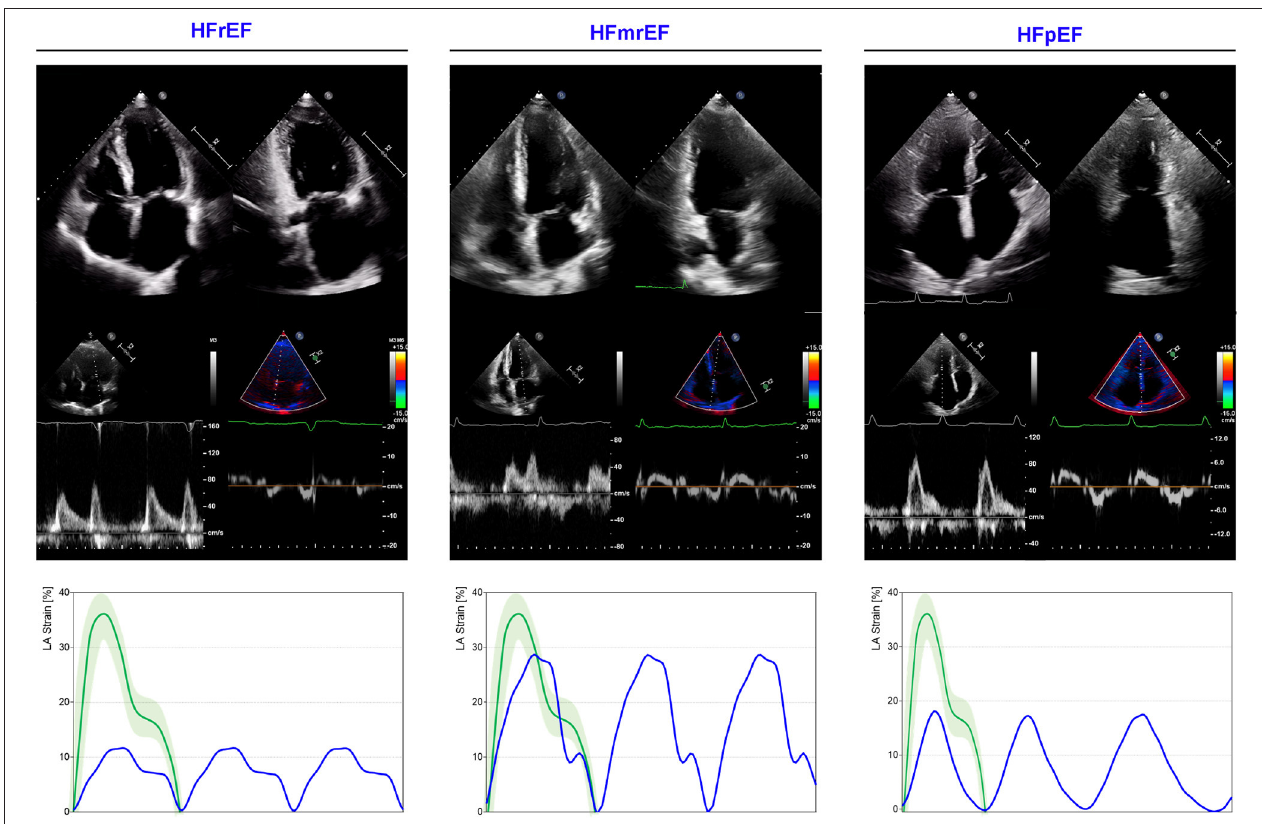
FIGURE 6 | LA mechanics in HF subtypes. Examples of echocardiographic images and LA strain are shown for HFrEF (left) , HF with mid-range ejection refraction (HFmrEF; middle) and HF with preserved ejection refraction (HFpEF; right ). Strain traces are cartoons realized with real values of the reported cases. Reference values for LA strain are shown in green. Note that HFrEF has a very depressed LA function when compared with HFmrEF (expression of greater disease severity), while HFpEF presents a significantly impaired reservoir function (without contraction component for the presence of atrial fibrillation), similar to that observed in HFrEF. Abbreviations as in the